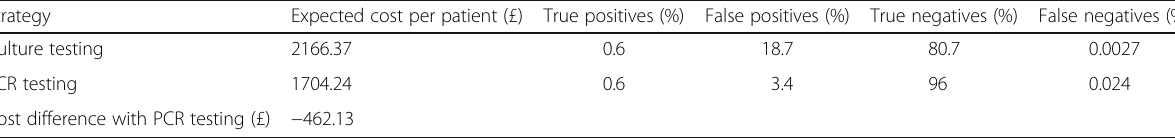
Table 2 Base-case analysis expected costs and test performance